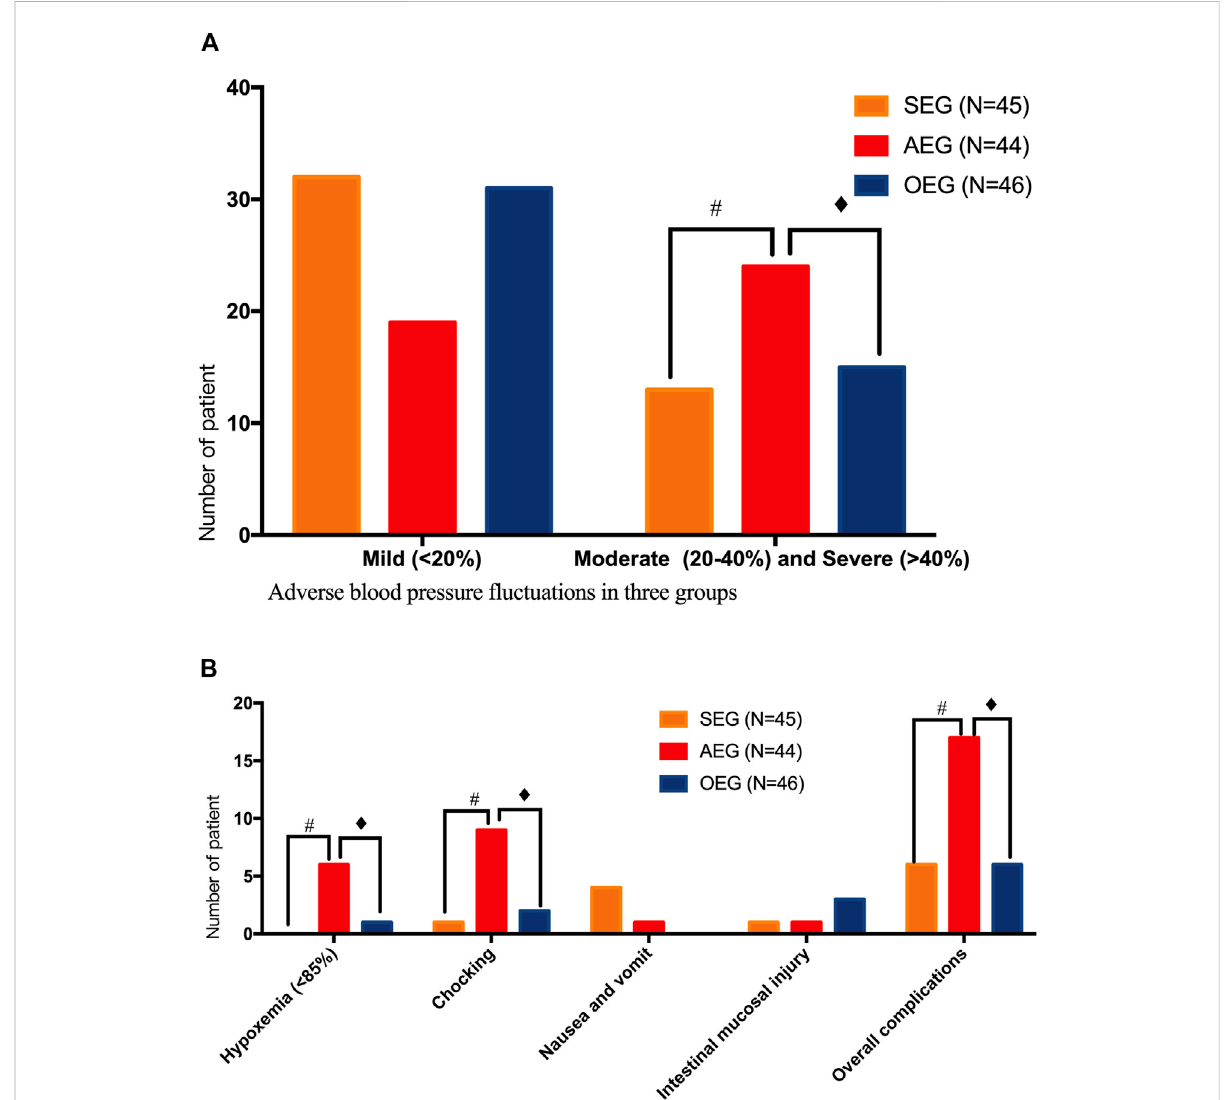
FIGURE 3 Safety assessment of gastrointestinal endoscopy in the different groups sedation-endoscopy-group (SEG), anesthesia-endoscopy-group (AEG), and ordinary-endoscopy-group (OEG). # Statistically signi fi cant difference between the SEG and AEG ( p < 0.05). ◆ Statistically signi fi cant difference between the OEG and AEG ( p < 0.05). (A) Comparison of adverse blood pressure fl uctuations in three groups; (B) Comparison of other adverse reactions and complications in three